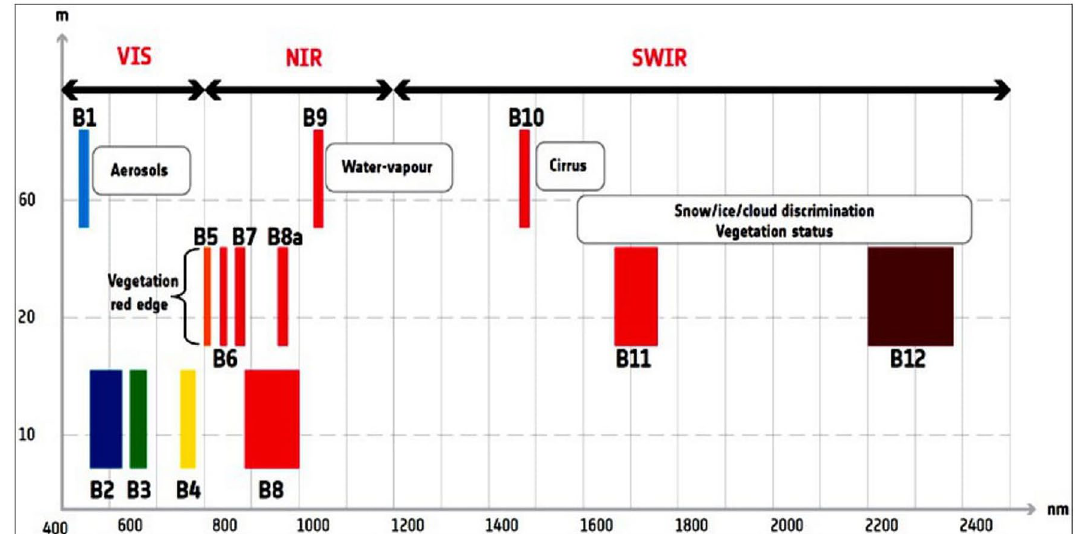
Figure 3. Sentinel-2 MSI spectral bands vs. spatial resolution with corresponding Full Width at Half Maximum [FWHM] 70 [ENVI 5.5 https ://www.harri sgeos patia l.com; https ://senti nel.esa.int/].